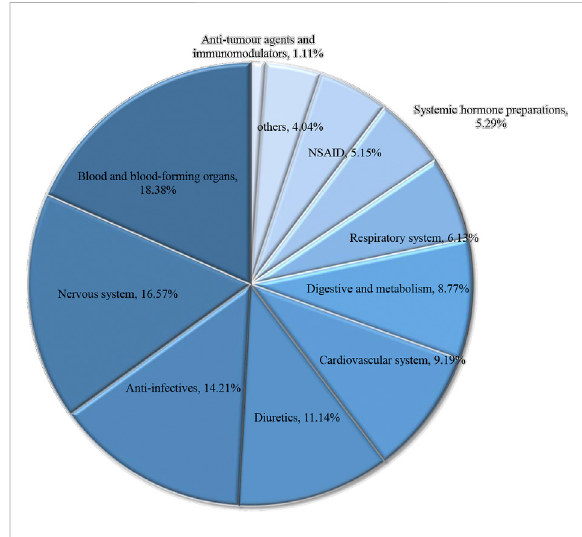
FIGURE 1 Drug categories and high frequency of drug for Pediatric patients with DIKI. Abbreviation: DIKI, drug-induced kidney injury.